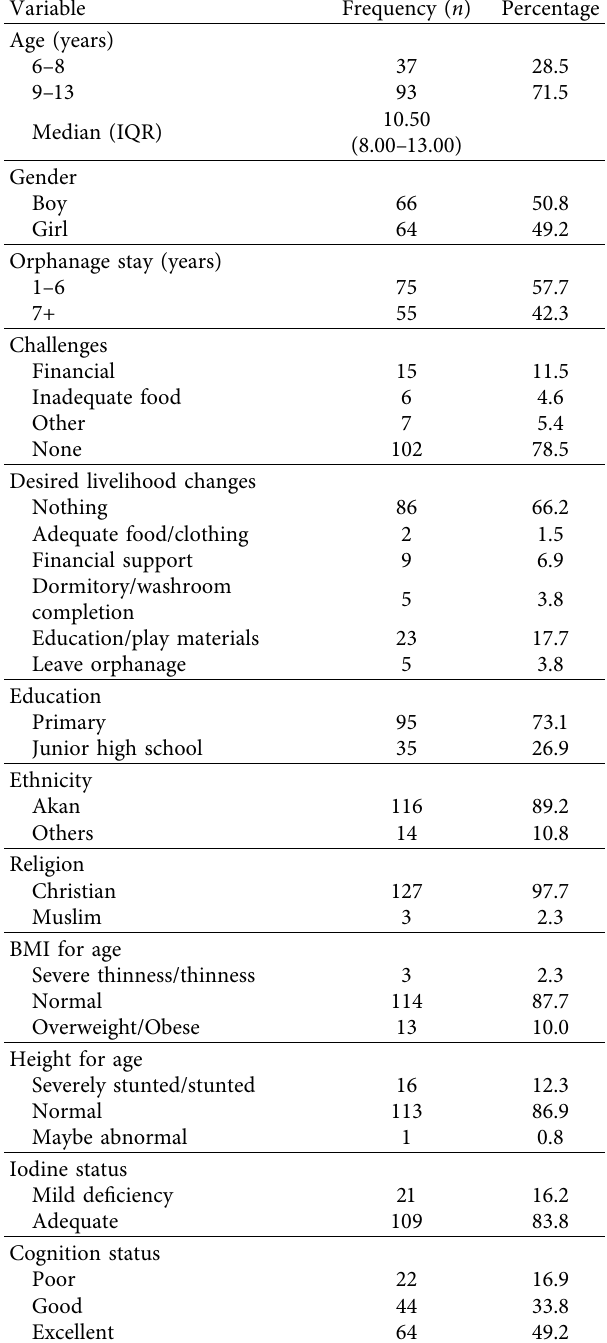
Table 1: Characteristics of